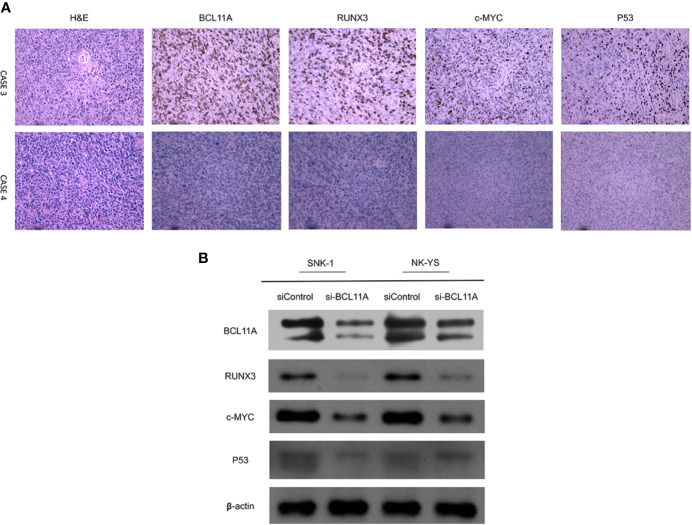
Correlation of BCL11A, RUNX3, c-MYC, and P53 protein expressing levels. (A) Representative images of immunohistochemical expression of BCL11A, RUNX3, c-MYC, and P53 protein in two natural killer/T-cell lymphoma (NKTL) samples. In case 3, BCL11A protein expressing level was high, along with high RUNX3, c-MYC, and P53 protein expressing levels. In contrast, case 4 with low BCL11A protein expressing level showed low RUNX3, c-MYC, and P53 protein expressing levels. (B) Protein expression of BCL11A, RUNX3, c-MYC, and P53 after BCL11A knockdown. After efficiently silenced BCL11A as showed in Figure 2, RUNX3, c-MYC, and P53 expression profiles were analyzed post 96 h after BCL11A knockdown. Silencing of BCL11A sequentially deregulated RUNX3, c-MYC, and P53 expression in NKTL cells.